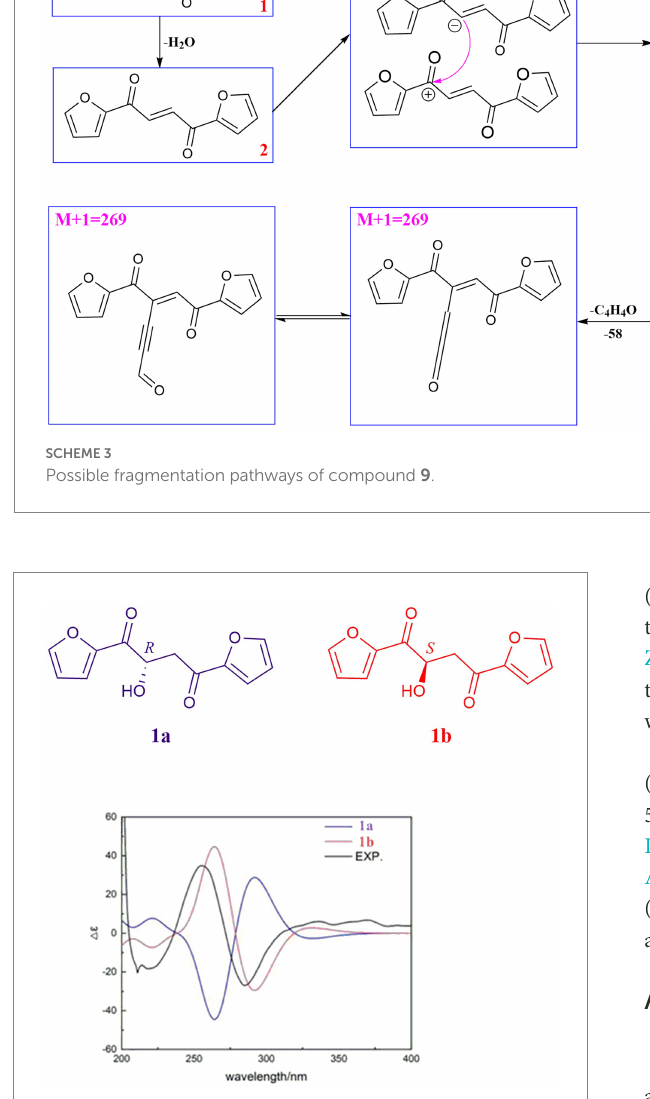
FIGURE 6 Experimental CD spectrum of 1 and calculated ECD spectra of 1a and 1b .